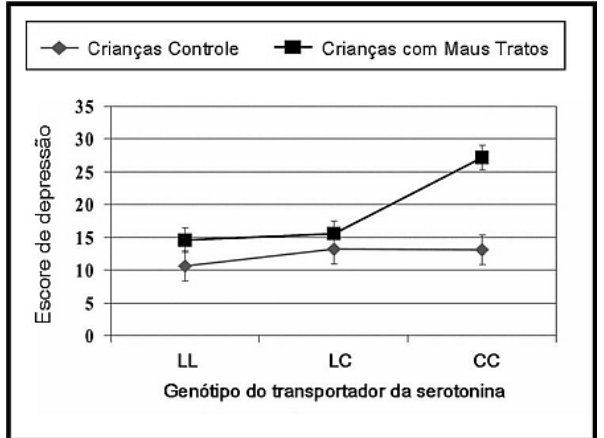
Figura 4 . Interação entre o genótipo da molécula transportadora da serotonina e maus tratos na infância nos escores de